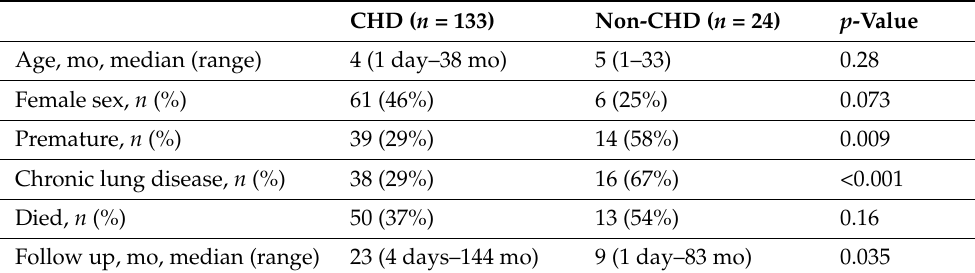
Table 5. Comparison of PVS patients with and without congenital heart